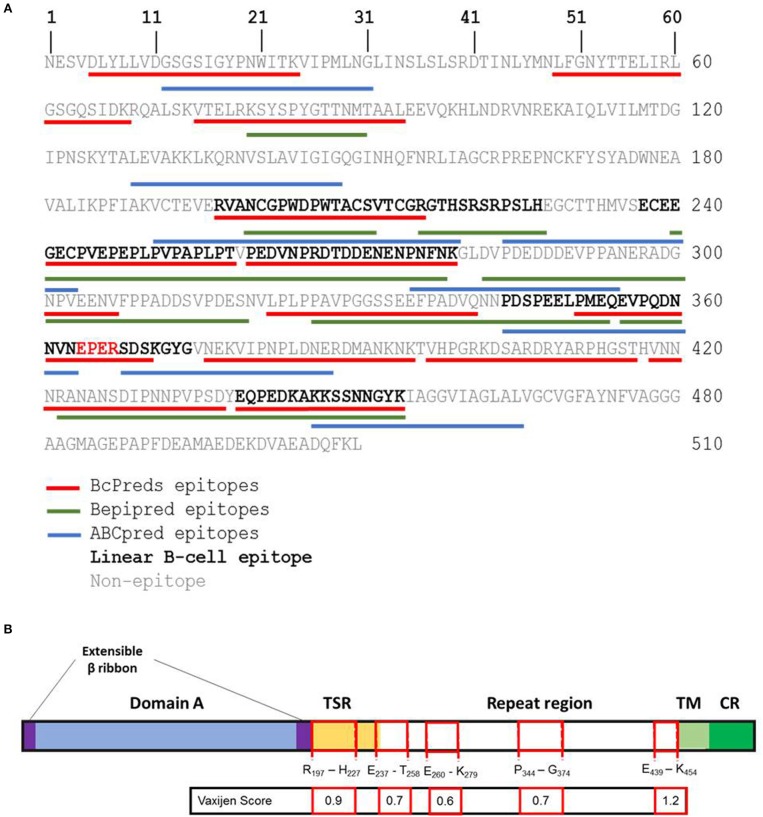
In silico identification of linear epitopes on PvTRAP. (A)
In silico prediction of linear epitopes on PvTRAP sequence. Letters on figure represent one letter amino acid code. Bcpreds, Bepipred, and ABCpred predicted epitopes were represented by red, green, and blue lines, respectively. Black bold letters indicate predicted epitopes. Sequences with more than 9-mers and predicted by at least two algorithms were considered B-cell linear epitopes. (B) Schematic diagram of PvTRAP and predicted linear B-cell epitopes. The black line box represents the PvTRAP. The blue box represents the domain A, the purple boxes are Extensible β ribbon, the yellow box represent the thrombospondin type 1 repeat (TSR) domain, the white box represents the repeat region, the light green box is the transmembrane region (TR) and dark green represents the cytosolic region (CR) of PvTRAP. Predicted linear B-cell epitopes were illustrated by red line boxes and the first and the last amino acids of each epitope were indicated. The Vaxijen Score indicates the value of predicted antigenicity of each epitope.